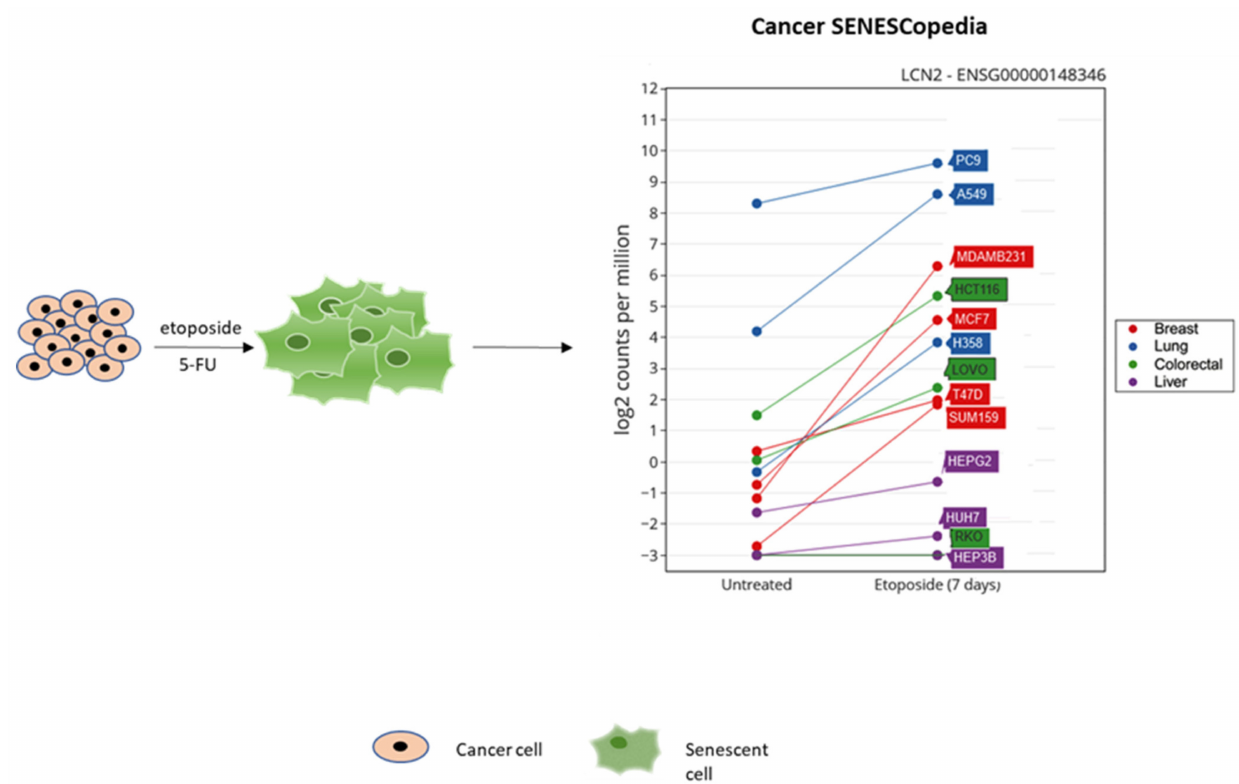
Figure 2. NGAL expression in etoposide-induced senescent cancer cell lines. Adapted from Cancer SENESCopedia (https://ccb.nki.nl/publications/cancer-senescence/, assessed on 10 November